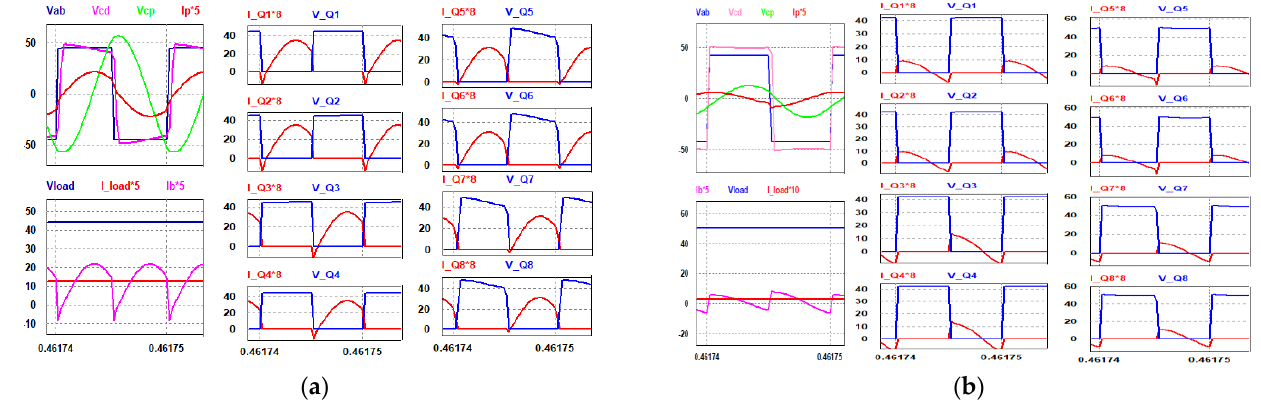
voltages and currents are shown in Figures 9–11. Simulation waveforms of the CFIBDC for Case 1 are shown in Figure 9, and for Case 2 are shown in Figure 10. Case 3, with the current input to the IBDC converter i discharge from stored energy in a forward mode, which is fed back, is also shown in Figure 11. Soft switching is achieved for the switches Q 1 to Q 8 at full load; the corresponding voltage and current waveforms are offered for the corresponding voltage and current waveforms are offered for both forward and re- both forward and reverse modes of operations. Various losses of the converter are used verse modes of operations. Various losses of the converter are used for the simulation of for the simulation of the losses and efficiency of the converter. The simulation results and the losses and efficiency of the converter. The simulation results and theoretical calcula- theoretical calculations are compared and found to be approximately equal, as can be seen tions are compared and found to be approximately equal, as can be seen in Table 3. in Table 3.